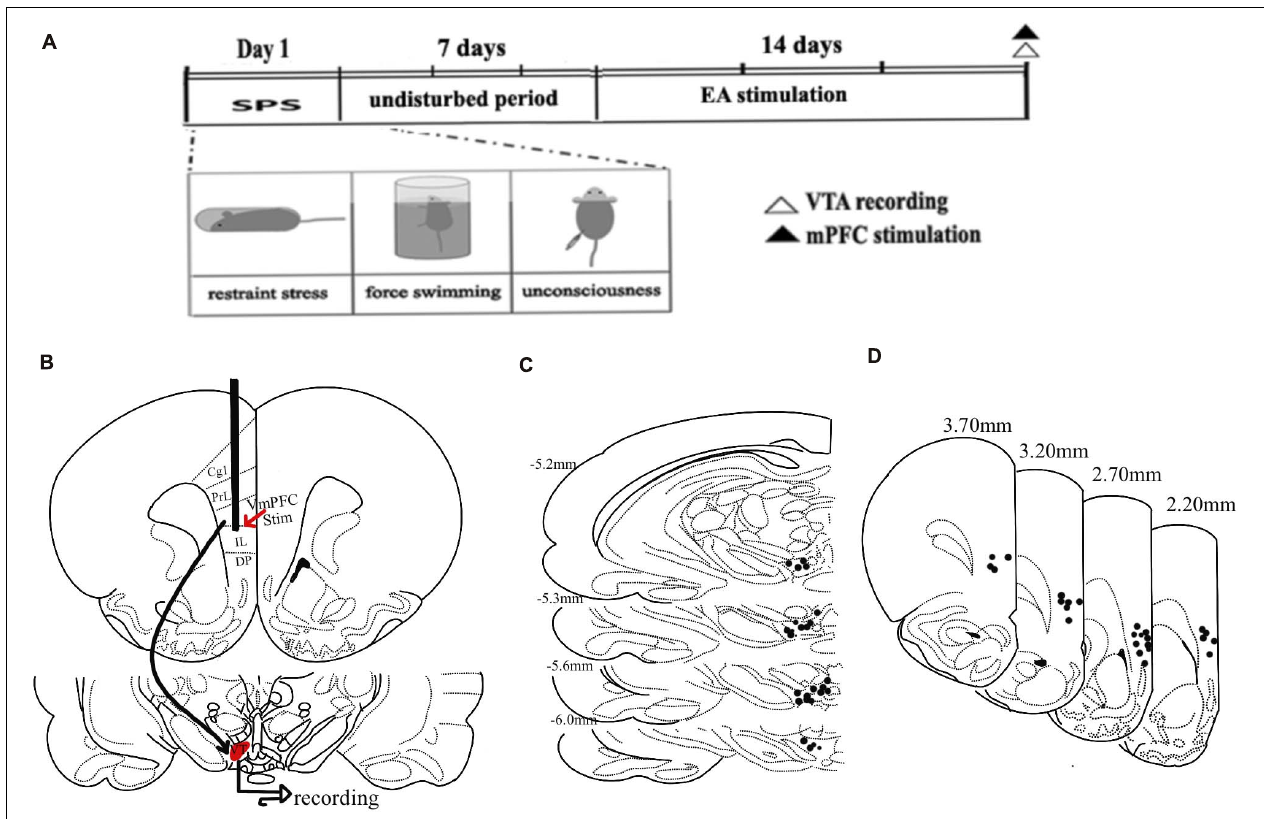
FIGURE 5 | Experimental timeline overview and vmPFC stimulation and recording site schematics. (A) A timeline of MSPS modeling, EA treatment, electrophysiological stimulation, and recording. (B) An overview of the vmPFC electrophysiological stimulation and recording sites used for this study. (C) Plots of 55 histologically localized DA neurons within the VTA. (D) Hemisection plots of the prefrontal cortex indicating stimulation site